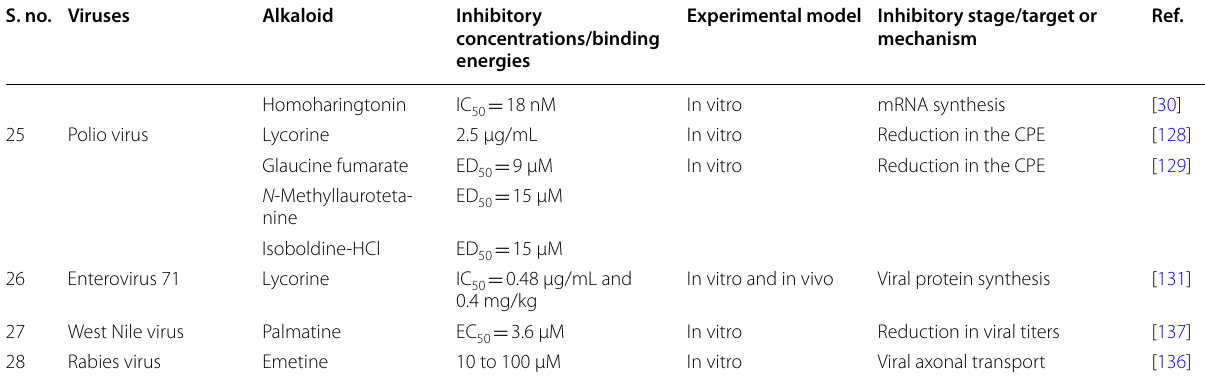
inhibitory concentration ( IC 50 ) of a medication is a measure of its efficacy. It denotes the amount of the drug required to inhibit a biological process by half. While binding free energy is the total of all intermolecular interactions between the ligand and the target